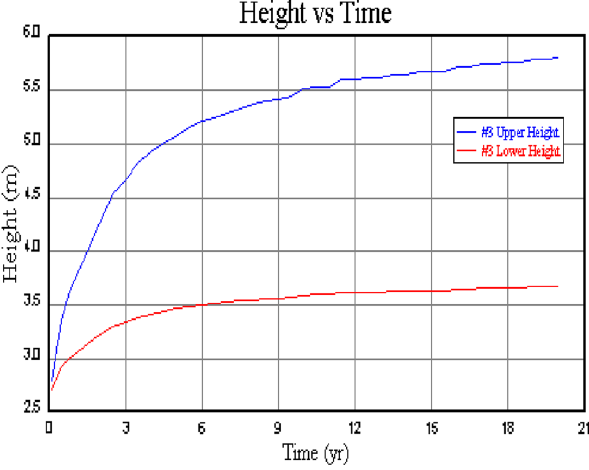
Fig. 15 Fracture height versus time